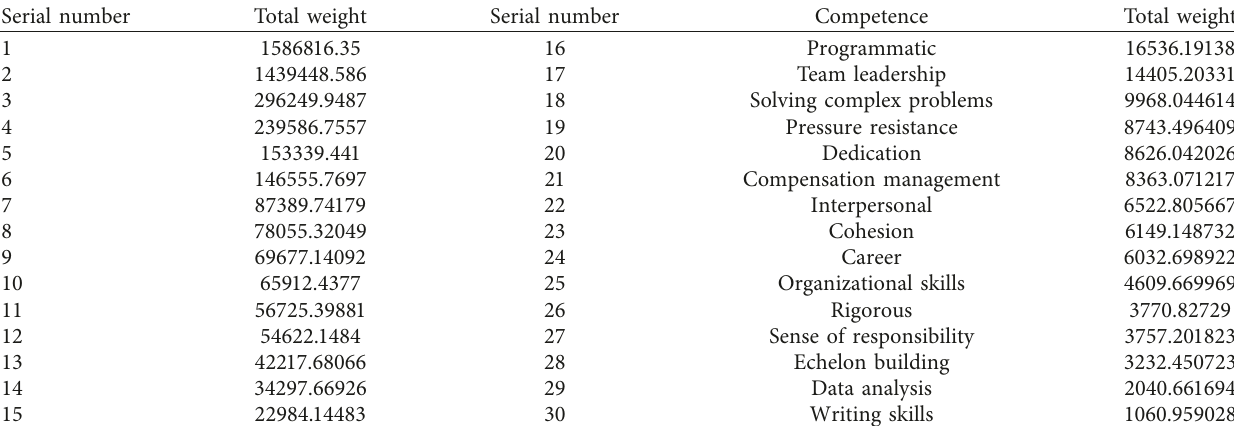
Table 4: Top 30 competent qualities by total weight